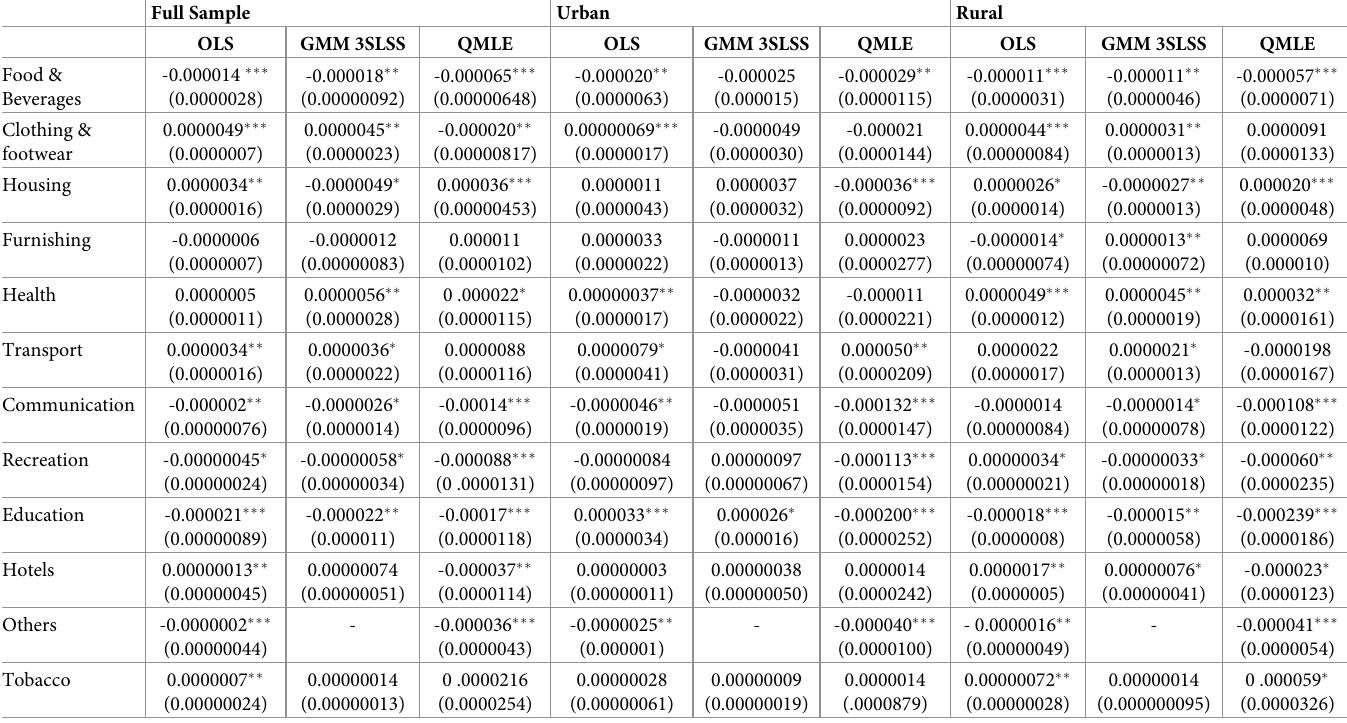
Table 4. QMLE estimation results for the crowding out effects of